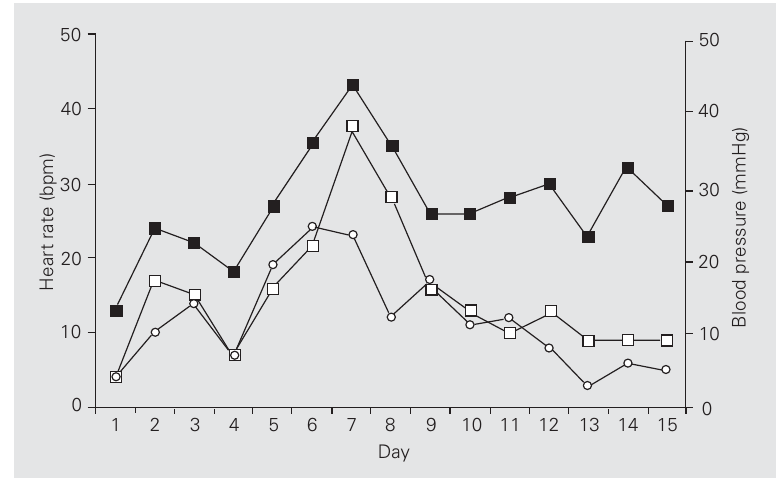
Figure 1. Heart rate and blood pressure changes in children with severe tetanus and autonomic dysfunction. Heart rate and blood pressure increased simultaneously and pro- gressively to a maximum by day 7. The heart rate (filled squares) decreased slightly but not significantly from day 7 to day 9. It then became stationary and persisted elevated there- after. In contrast, the systolic (open squares) and diastolic pressures (circles) decreased gradually and significantly until day 15. Data are reported as increases above the 95th percentile for age and sex. Standard errors were omitted for purposes of clarity in construct- ing the figure.